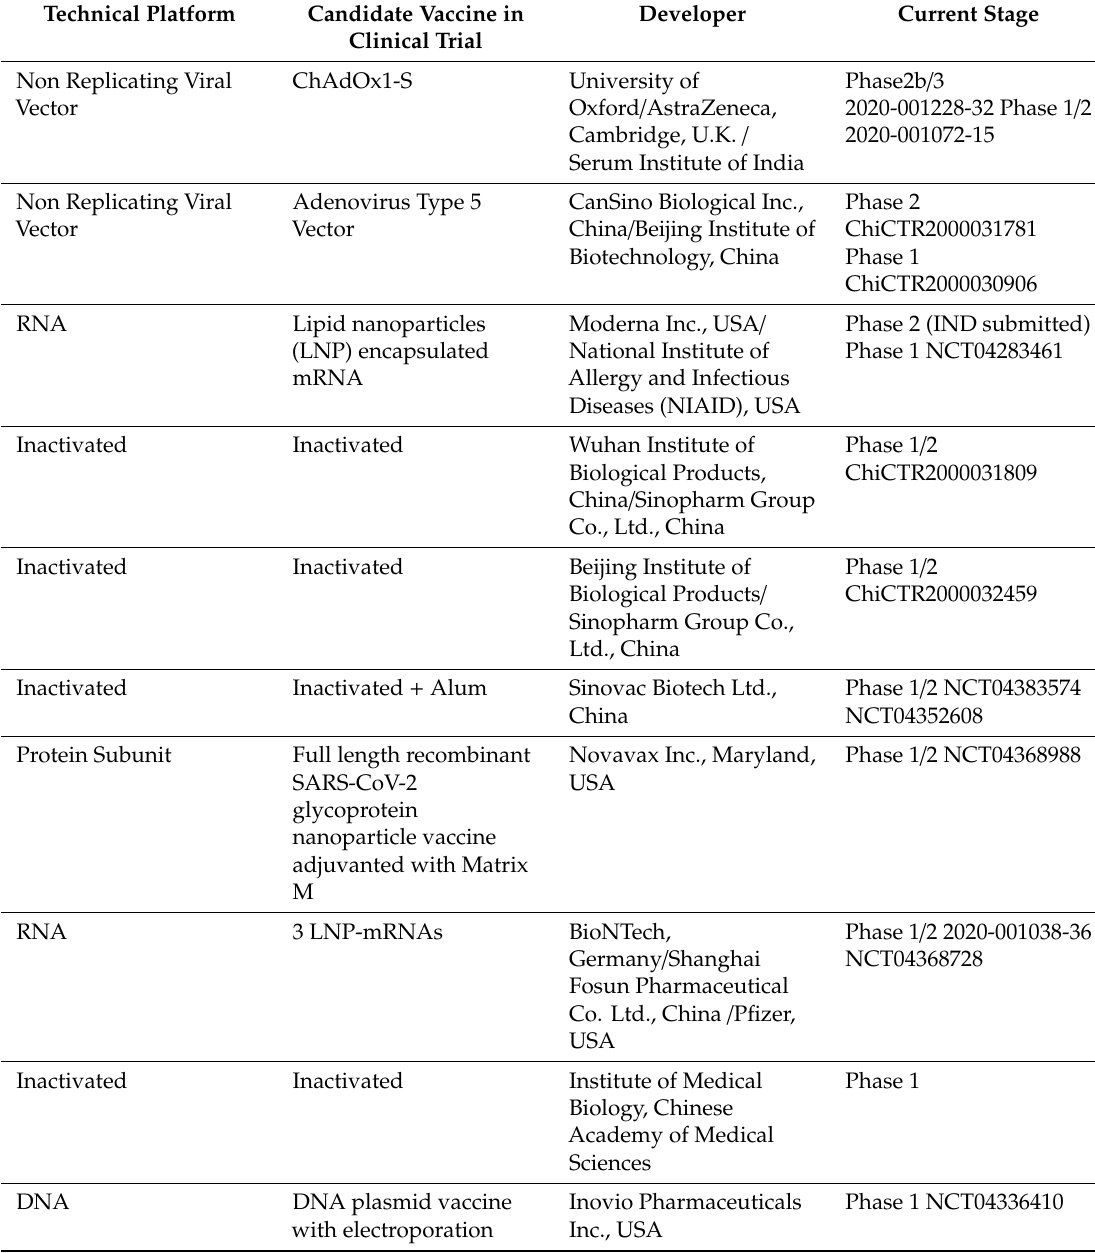
Table 1. Details of vaccines under clinical